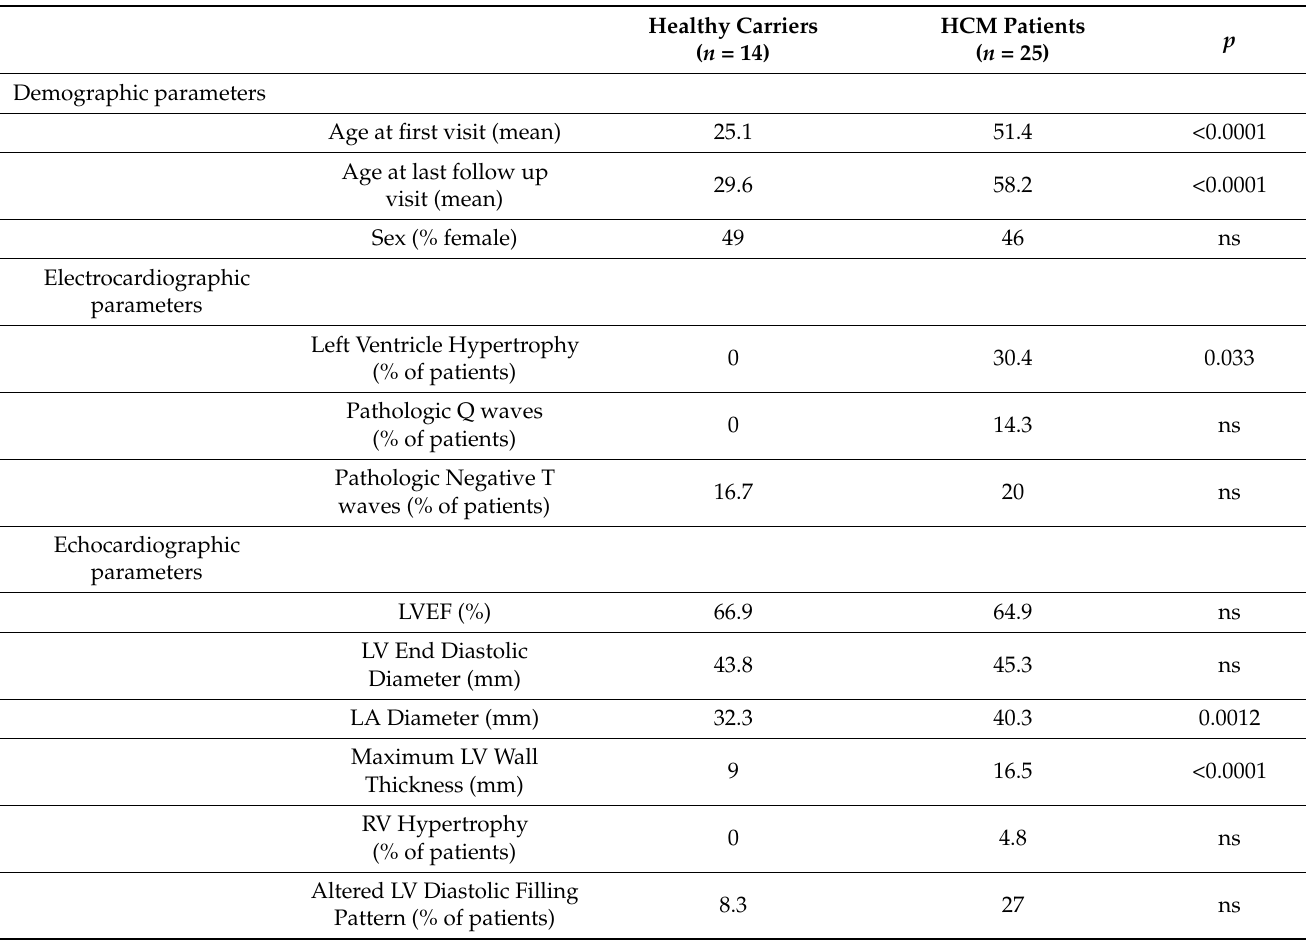
Table 2. Demographic, electrocardiographic, and echocardiographic characterization of healthy carriers and HCM